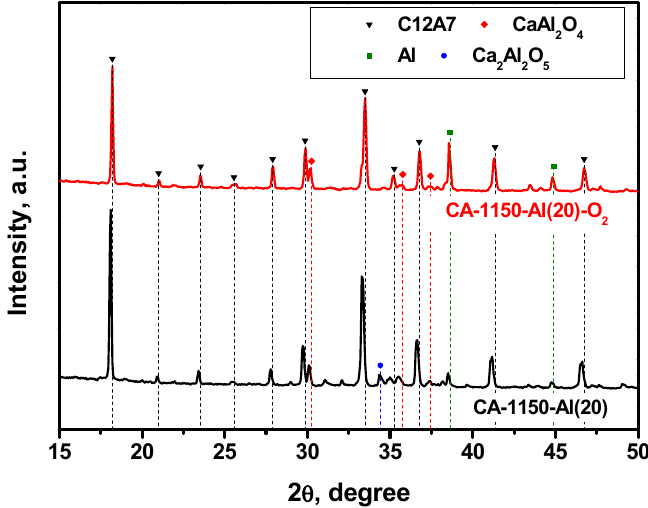
Figure 4. XRD patterns for the CA-1150-Al(20) samples calcined in argon and air at 1150 °C.